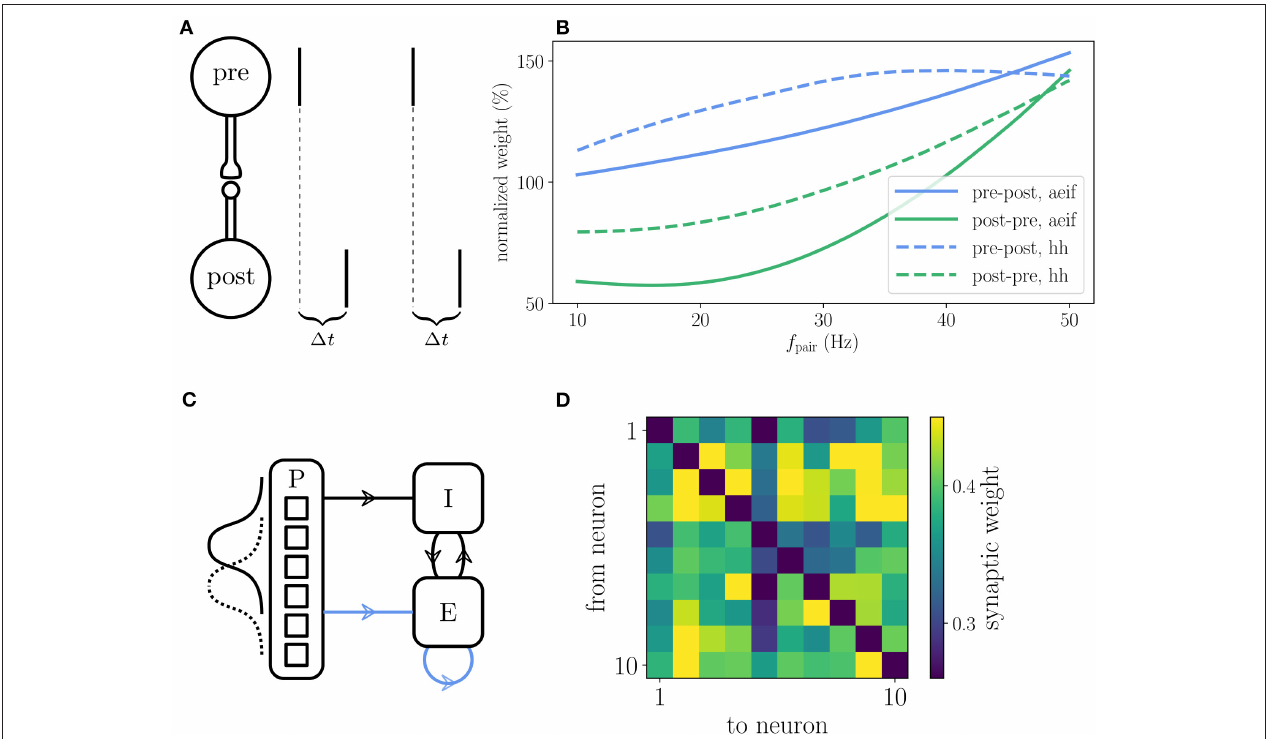
FIGURE 7 | Reproduction of results with Clopath rule. (A) Setup of the spike pairing experiment. Two neurons (“pre” and “post”) that are connected by a plastic synapse receive input so that they spike one after another with a delay 1 t . The change of the synaptic weight is computed according to the Clopath rule as a function of the frequency f pair with which the spike pairs are induced. (B) Result of the spike pairing experiment. The relative change of the synaptic weight after five spike pairs as a function of f pair is shown for two different neuron models (aeif: solid curves, Hodgkin-Huxley: dashed curves). The blue curves represent a setup where the postsynaptic neuron fires after the presynaptic one (pre-post, 1 t = 10ms) and the green curves represent the opposite case (post-pre, 1 t = − 10ms). This panel corresponds to Figure 2B of Clopath et al. (2010). (C) Setup of the network that produces strong bidirectional couplings. The network consists of an inhibitory (I) and an excitatory (E) population which receive Poisson spike trains (P) as an external input. The firing rate of the latter is modulated with a Gaussian shape whose center is shifted every 100ms. The external input connections to the excitatory population are plastic as well as the connections within the excitatory population (indicated by blue arrows). (D) Synaptic weights of the all-to-all connected excitatory neurons after the simulation of the network. Strong bidirectional couplings can be found, e.g., between neurons 2 and 3, 2 and 9, and 4 and 7. The setup of this experiment is similar to that shown in Figure 5 of Clopath et al. (2010). A more detailed description of the two experiments can be found in Appendix Section 5.4